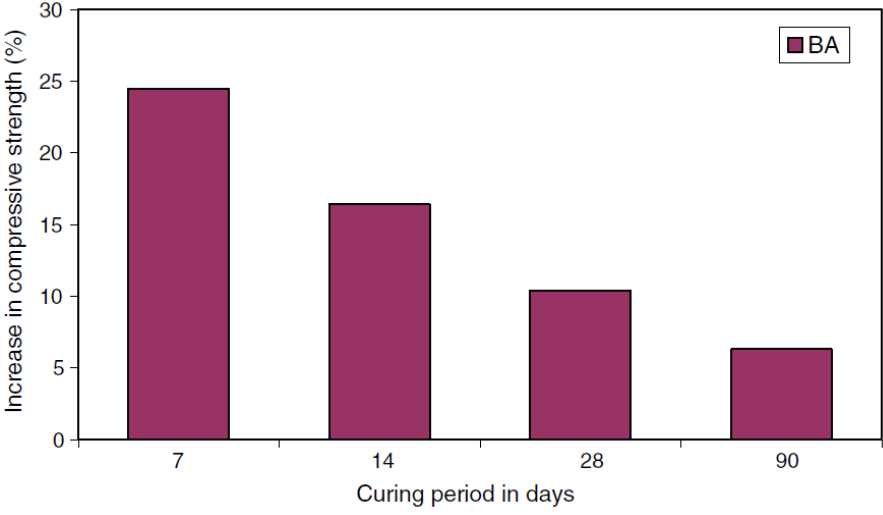
Figure 5. Relative increase in compressive strength of 20% SCBA blended concretes [52].